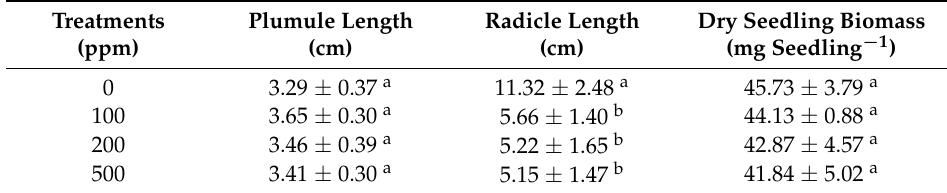
Table 1. Effect of zinc oxide naoparticles (ZnO-NPs) on plumule and radicle length, and fresh seedling weight of Capsicum annuum L.